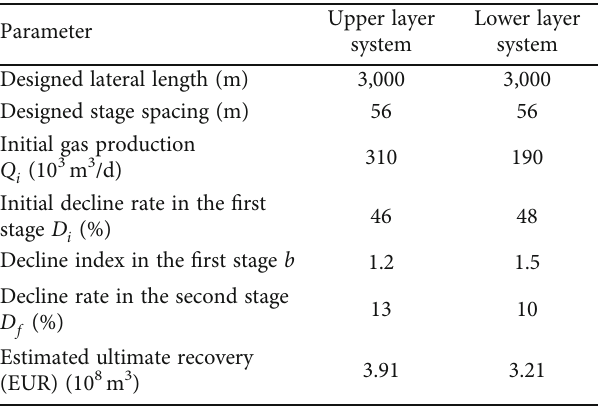
Table 3: Primary parameters of the type wells with designed completion parameters in S